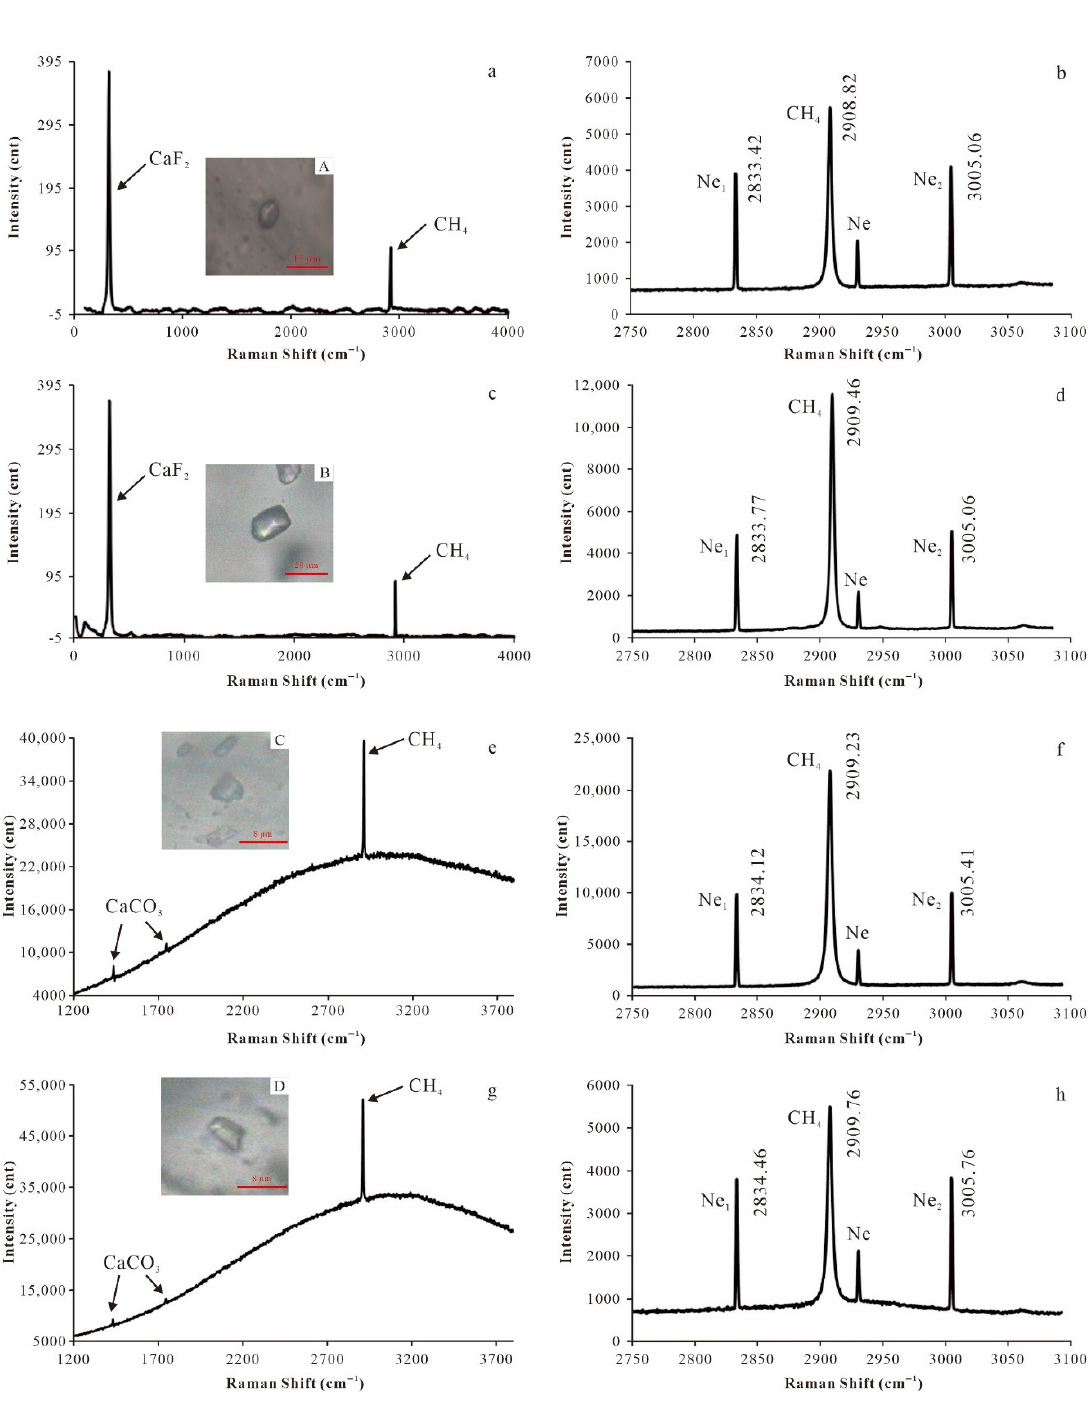
Figure 5. ( a , c , e , g ) Laser Raman spectra collected from pure methane inclusions A, B, C, and D with 300 groove/mm grating; ( b , d , f , h ) laser Raman spectra of CH 4 in pure methane inclusions A, B, C, and D with 1800 groove/mm grating. Ne 1 and Ne 2 are two bands corresponding to the Ne lamp scattering bands of 2836.99 cm − 1 and 3008.13 cm − 1 , respectively. Methane inclusions A and B were trapped in fluorites from the Wujiahe orebody, and the other two methane inclusions C and D were trapped in calcites from the Laoxi orebody.